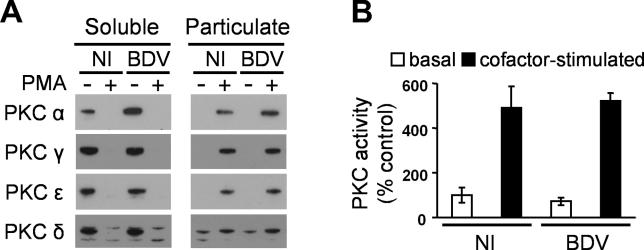
Analysis of PKC Activation(A) Cytosol-to-membrane recruitment of PKC. Subcellular distribution of PKC isoforms in NI and BDV-infected neurons after treatment with PMA. The detergent-soluble and particulate fractions, corresponding to cytosolic and membrane fractions, were subjected to Western blots for the detection of PKCα, PKCγ, PKCɛ, and PKCδ. Note the shift in the subcellular distribution of PKC isoforms after treatment with PMA. Results are representative of three independent experiments.(B) In vitro measurements of basal and cofactor-stimulated PKC activities. The cofactor-stimulated specific activity represents kinase activity in the presence of Ca2+ and lipid activators. Results are expressed as percentage of increase over the mean of unstimulated controls.